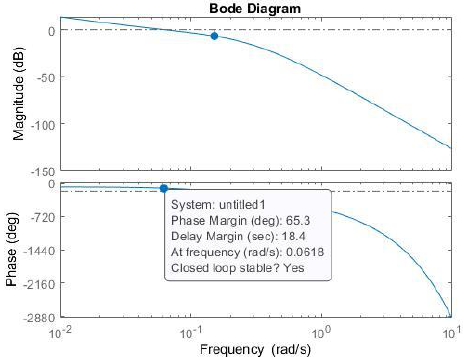
Figure 7. Bode diagram of the open-loop system for the second designed FO-PI controller.